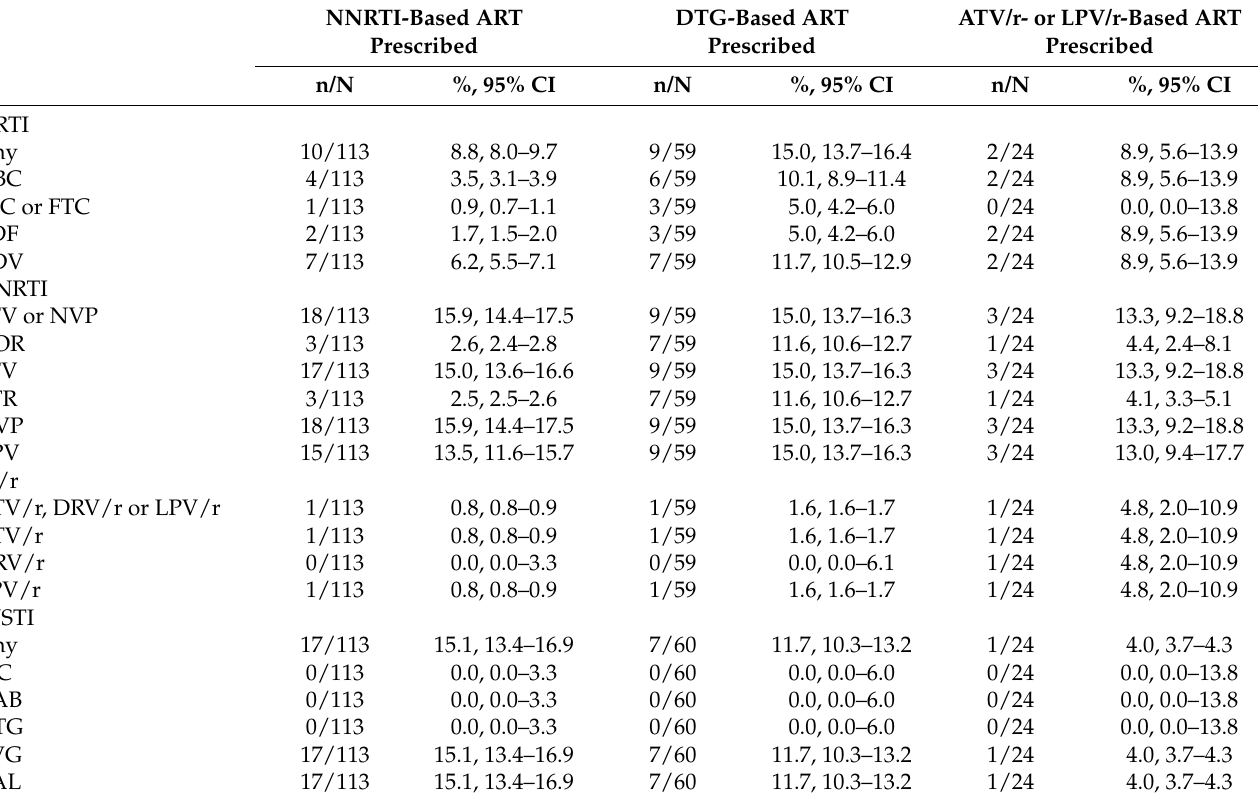
Table 5. Prevalence of HIV drug resistance among adults initiating and reinitiating ART in Uruguay by regimen prescribed,